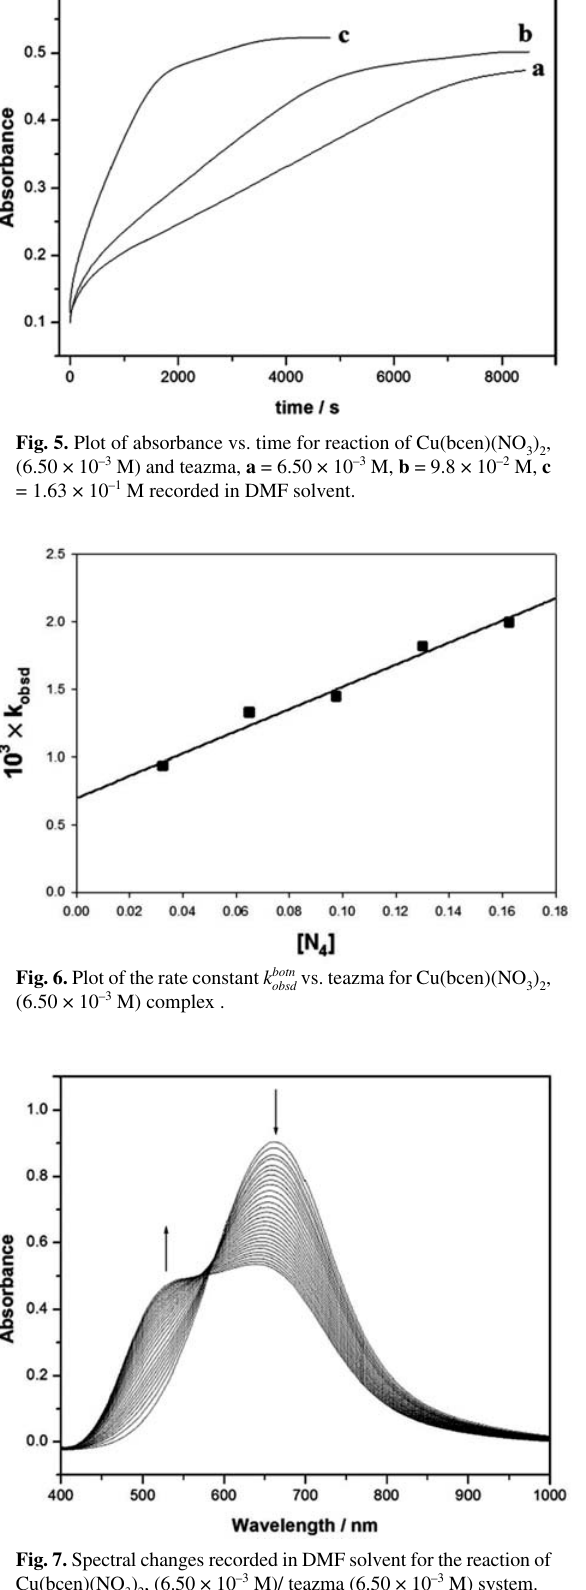
Fig. 7. Spectral changes recorded in DMF solvent for the reaction of Cu(bcen)(NO ) , (6.50 × 10 –3 M)/ teazma (6.50 × 10 –3 M) 3 2